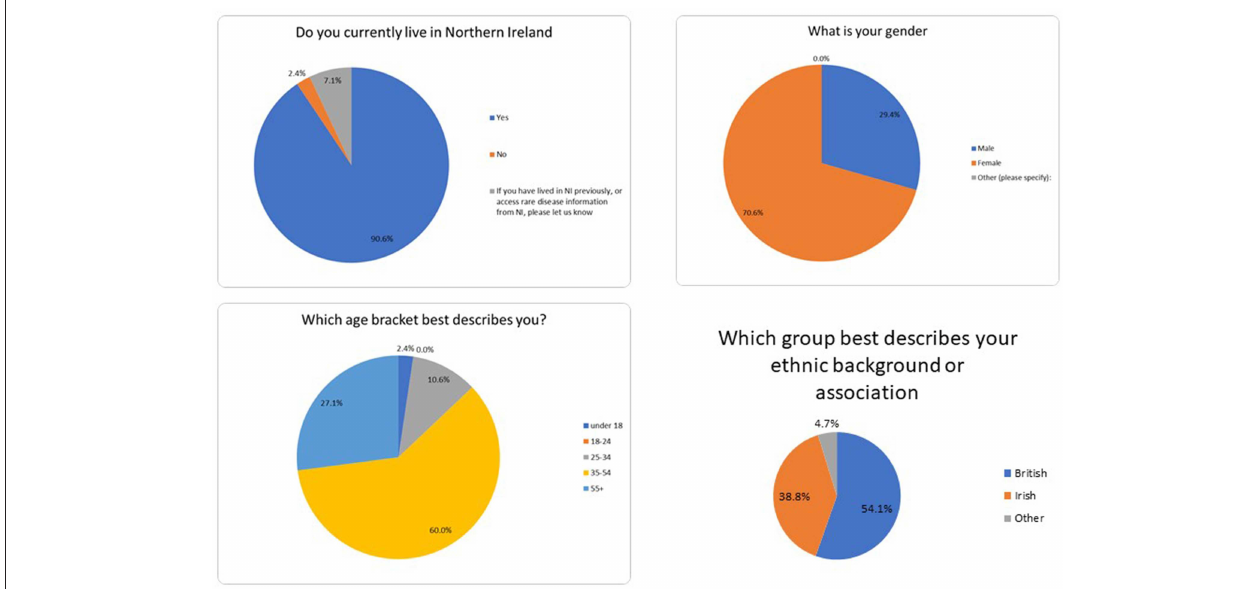
FIGURE 2 | Sociodemographic information from respondents.